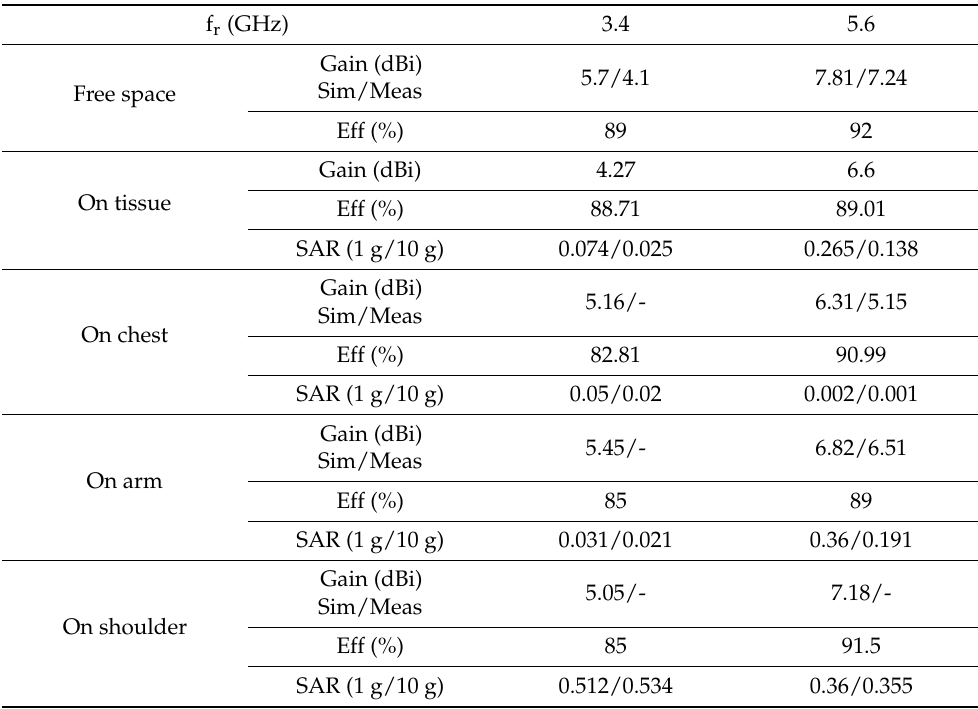
Figure 17. SAR evaluation of the proposed antenna at the proximity of voxel human arm, shoulder, and chest (( a , e , i ) at 3.4 GHz, 1 g; ( b , f , j ) at 3.4 GHz, 10 g; ( c , g , k ) at 5.6 GHz, 1 g; ( d , h , l ) at 5.6 GHz, 10 g). Table 3. Antenna’s performance comparison in three different mediums as free space, body tissue, and voxel body (arm, chest, shoulder).